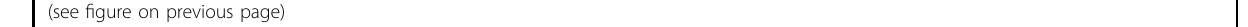
Fig. 5 A theoretical model guides conditions under which otherwise irreversible phenotypic transition can be reversed by inhibiting the mechanical PFL and reducing elastic modulus of matrix. a Schematic diagram of the matrix stiffness-induced integrin β 1-Piezo1 PFL and the mathematical description of the loop ( C I , integrin concentration; C P , Piezo1 concentration; C a , CF activation; S ( t ), Elastic modulus; F ( t ), feedback strength). b Modeling results indicated that bifurcation (bistability, that is from reversible state to irreversible state) occurred when F [ t ] increased. c Modeling results indicated that activation became irreversible following exposure to suf fi ciently stiff matrices for suf fi ciently long-time intervals. d CFs were cultured on the plate (blue) in growth media for 1 – 14 days before trypsinization and transfer (light green, day 0) to soft hydrogels (orange). CFs were cultured subsequently on soft hydrogels for 1 and 7 days in growth media before collection and analysis (grey, day 1 and 7). e Immuno fl uorescence analysis of α -SMA in CFs after 1 and 7 days on soft hydrogels with different mechanical doses (blue, nucleus; green, a-SMA; red, F-actin). Scale bar, 50 μ m. f RT-PCR analysis of α -SMA, Col 1 and PDGFR- α in CFs after 1 or 7 days on soft hydrogels with various mechanical doses. g , h Immuno fl uorescence analysis of integrin β 1 and Piezo1 in CFs after 7 days on soft hydrogels and 21 days on stiff hydrogels (green, integrin β 1; grey, Piezo1; red, F-actin). Scale bar, 10 μ m. i Quanti fi cations of length of adhesions in panel g ( n ≥ 124 data points). j RT-PCR analysis of integrin β 1 and Piezo1 in CFs after 7 days on soft hydrogels and 21 days on stiff hydrogels. k Our mathematical model predicted that inhibiting feedback strength can reverse activation of CFs. l Phase diagram illustrating the irreversibility of cardiac fi brosis with respect to the feedback strength and concentration of PFL inhibitors. m CF activation can be reversed, to the greatest extent, by simultaneously inhibiting the mechanical PFL and reducing matrix elastic modulus. n , o GsMTx4 (Piezo1 inhibitor) and the combination of PLX4720 and PF562271 (inhibiting integrin β 1) reduced activation of fi broblasts in conditions for which phenotypic reversal was otherwise impossible (St14), as seen by Western blot and immuno fl uorescence analysis. Scale bar, 50 μ